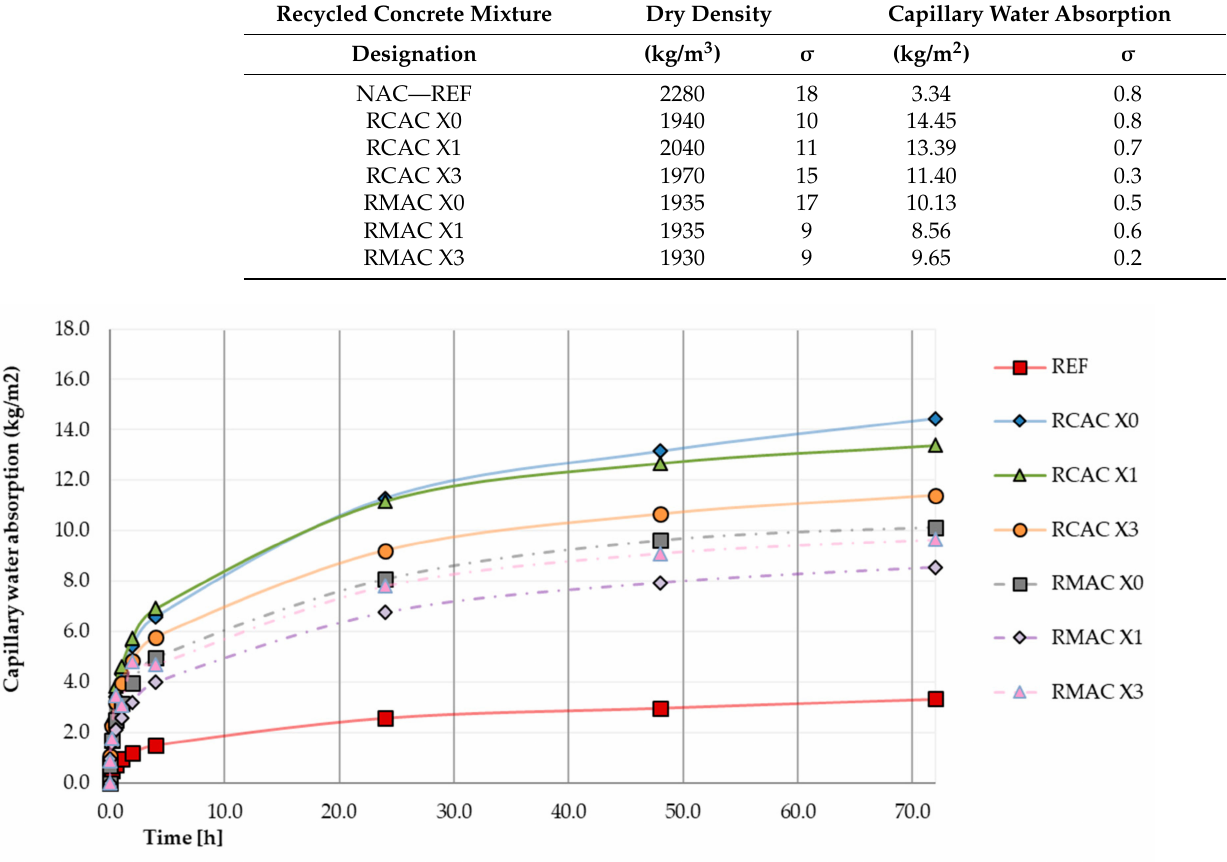
Table 4. Average values of results of physical properties of concrete, including standard deviation.